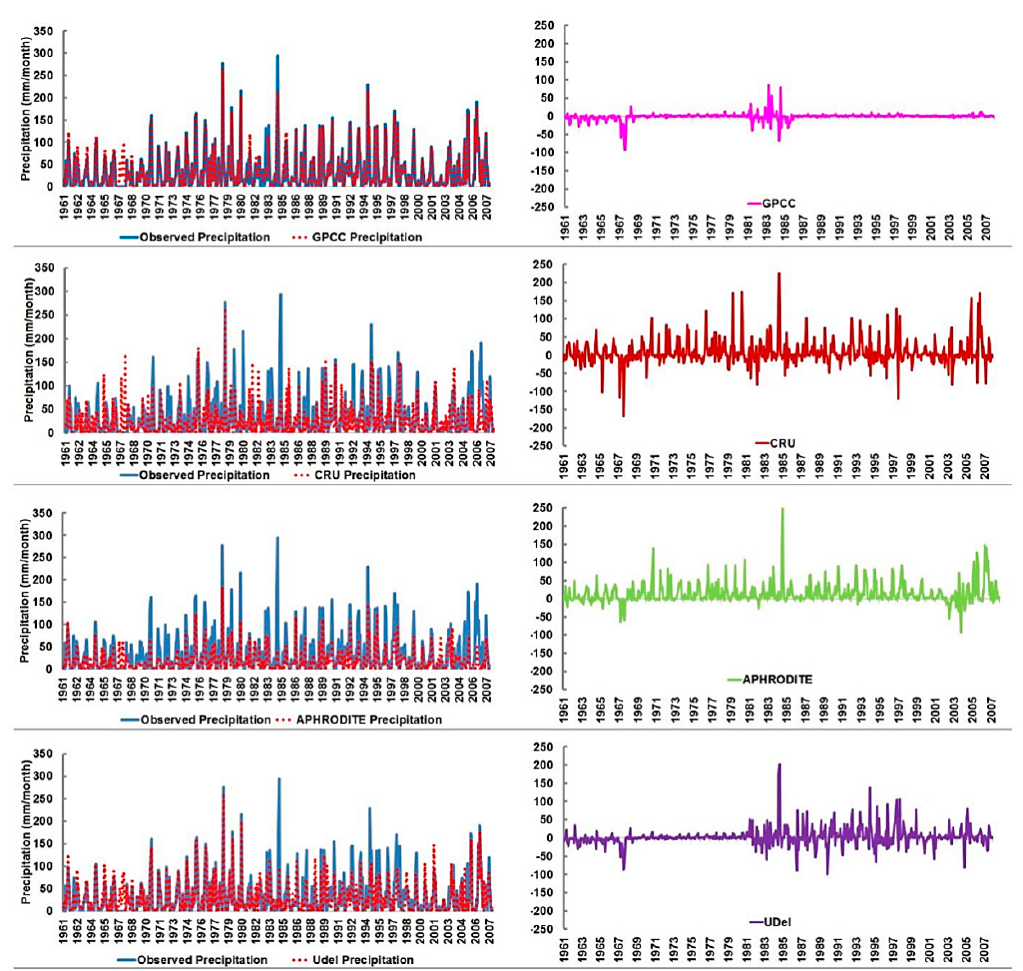
Figure 3. Time series of observed with gauge-based gridded precipitation, and residuals at the semi-arid region.